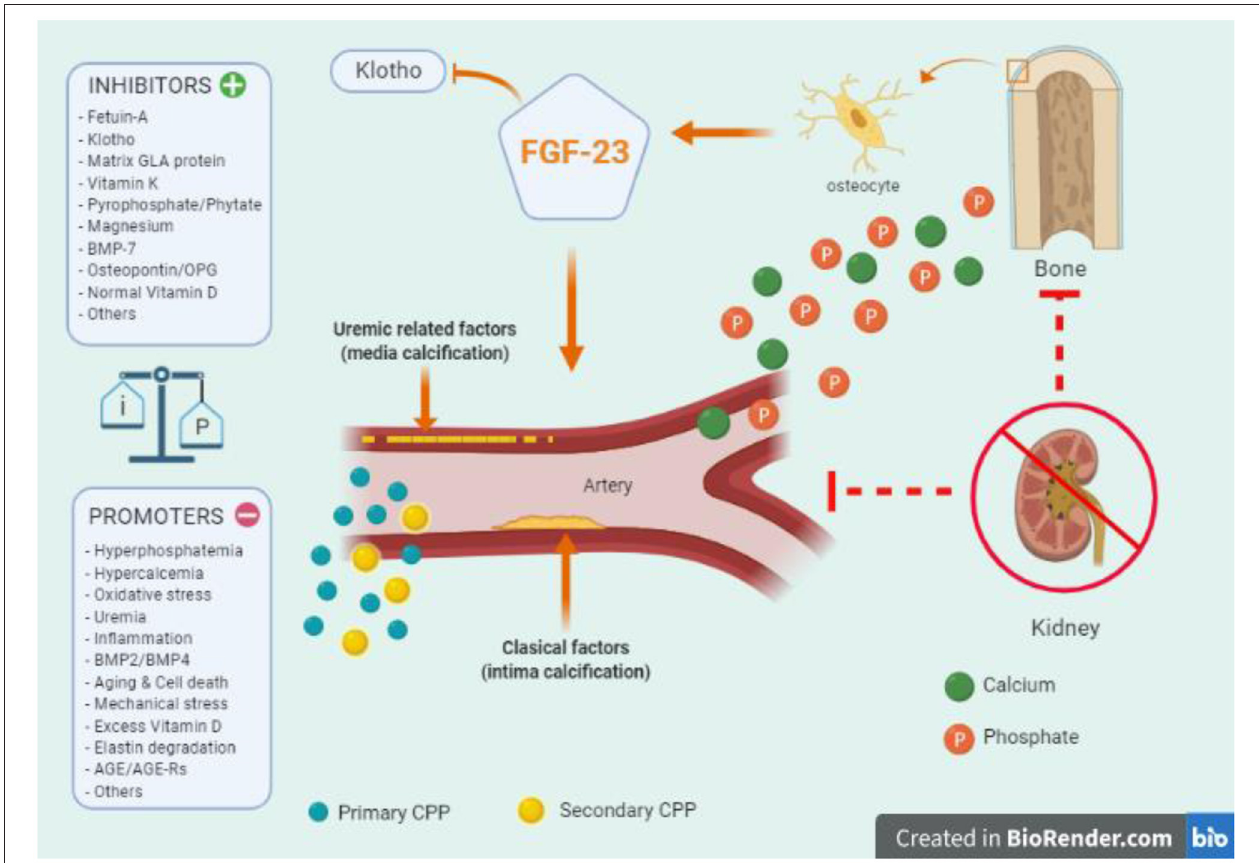
FIGURE 2 | Key aspects of vascular calcification (VC) in chronic kidney disease (CKD): the important balance between calcification contributors and inhibitors (tissue or circulating factors) in the pathophysiology of vascular calcification. The altered balance between calcification contributors and inhibitors makes CKD patients more or less susceptible to accelerated calcifications. Of note, CKD patients exhibit both types of VC, intimal atheroma calcification, and medial arteriosclerosis. A key role in the initiation and propagation are calcium (green) and phosphate (orange) ions. The passive formation of calciprotein nanoparticles (CPP) act as active precursors of micro-calcification. Initially, the small calcium/phosphate complex can be removed by Fetuin-A, which can eventually become saturated leading to primary CPP (light blue) that can develop secondary CPP particles (yellow). Later, phosphate entries into vascular smooth muscle cells producing osteochondrocytic transdifferentiation (vascular “ossification”). Many of the contributors may also promote this phenotypic osteochondrocytic transdifferentiation. Among them, tissue non-specific alkaline phosphatase (TNAP), aldosterone, parathyroid hormone, activin-A, collagen I, osteocalcin, osteonectin, oxidized-low density lipoproteins, have been associated with vascular calcification. On the other hand, parathyroid hormone related-peptide, collagen IV, high density lipoproteins, nitric oxide, and others, have been described as potential inhibitors. At the bone level, the role of FGF-23 and the co-factor Klotho are relevant in all the process, and a genetic background (e.g., proteins derived from Ank, Npps, ENPP1 genes) should also be considered. BMP, Bone Morphogenetic Proteins; TNF- α , Tumor Necrosis Factor- α ; IL, Interleukin; AGE, Advanced-Glication End-products; AGE-Rs,